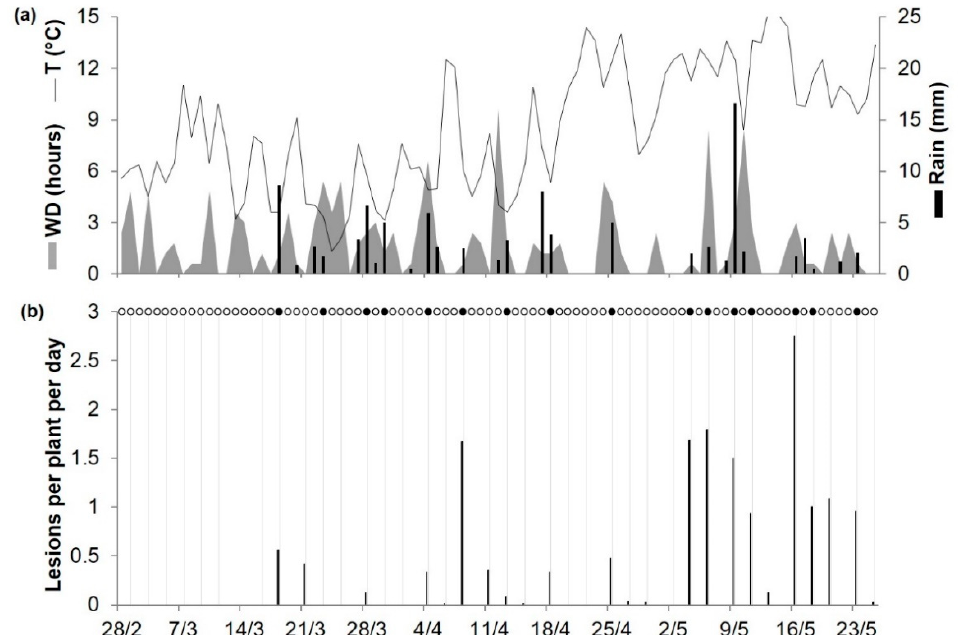
whiskers extend to minimum and maximum values, and the empty dot represents an outlier.